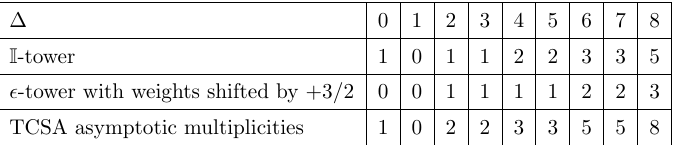
= 7, N (cid:15) = 21. max max